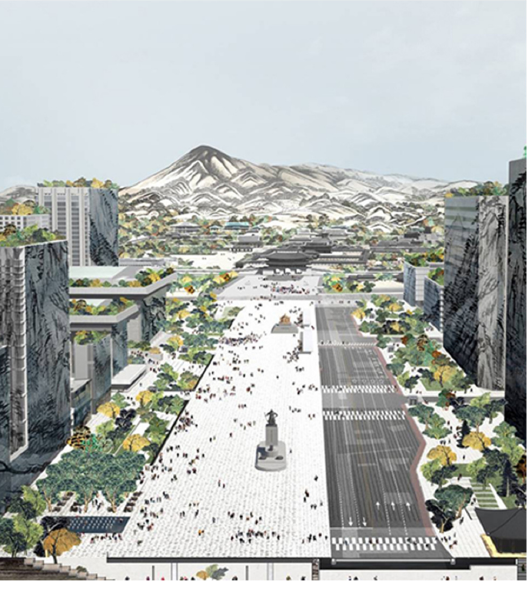
Figure 11. Bird’s eye view of Gwanghwamun Square (source: CA Landscape et al., [64]).